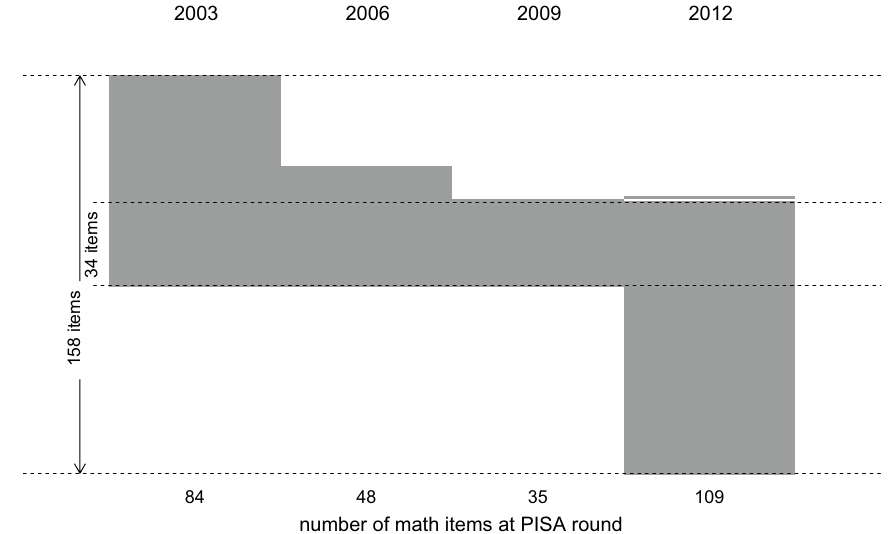
Fig. 1 PISA mathematics item linking across four rounds; I = 158 ; Common mathematics items linking single rounds: I = 48 (2003‑2006); I = 35 (2006‑2009); I = 34 (2009‑2012); I = 35